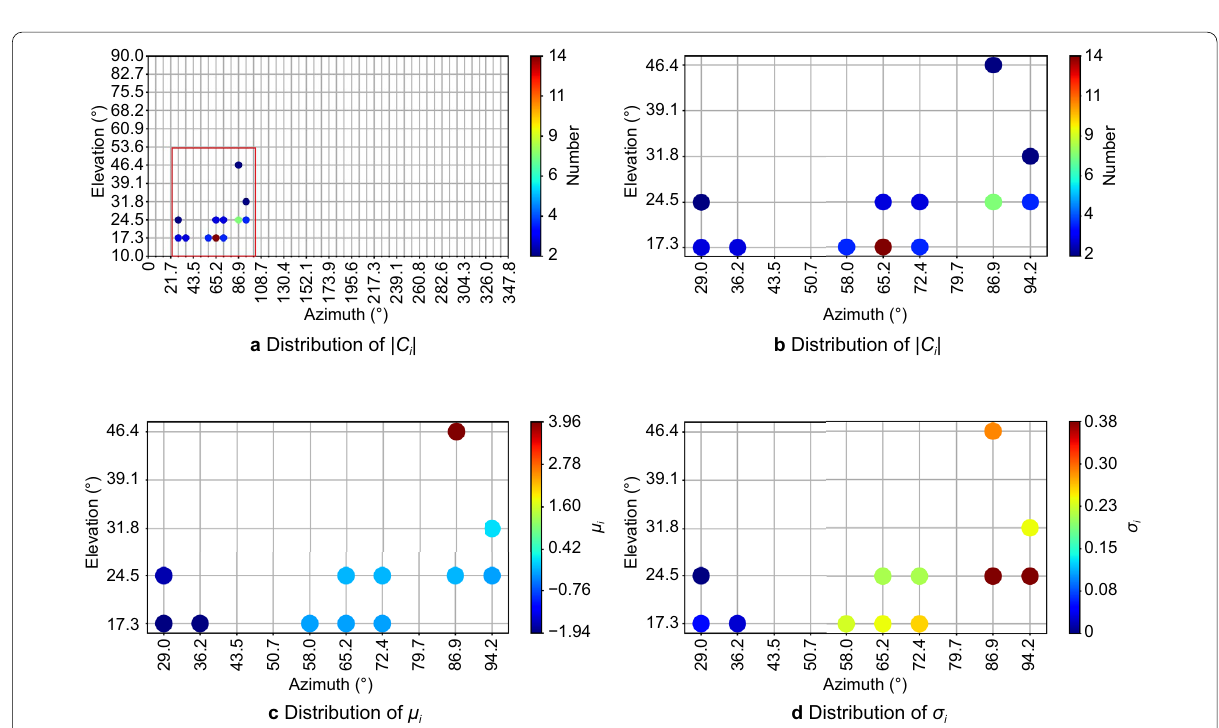
Fig. 6 Distribution of | C i | (the top two sub‑plots), μ i (the left‑bottom sub‑plot), σ i (the right‑bottom sub‑plot) in Eq. (7) against elevation angle and azimuth angle for latitude 65.6° and longitude 41.7° of solution B ( 24 × 16 × 12 × 50 ) on DOY 001,